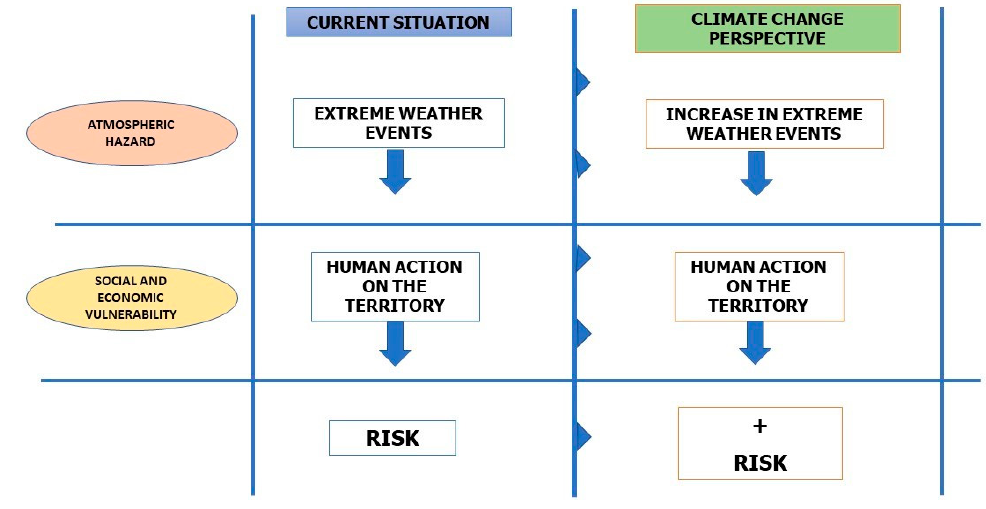
Figure 1. Societies at risk in the current context of global warming. Source: Own elaboration.